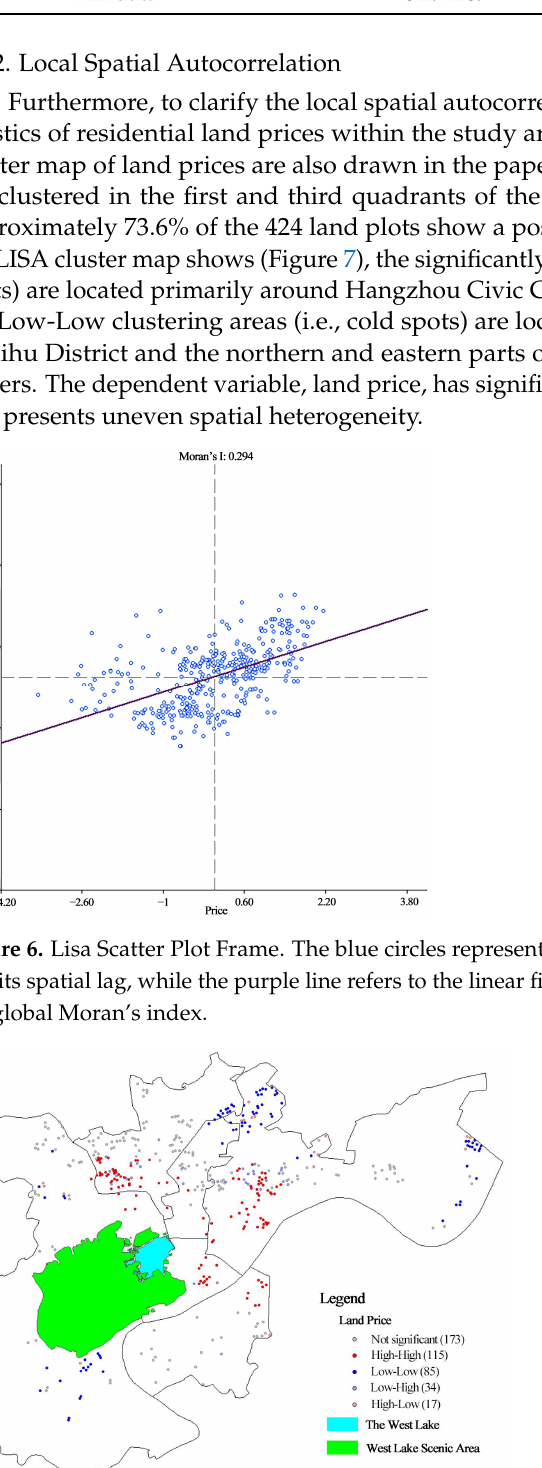
Table 2. Global Moran’s I for residential land price.